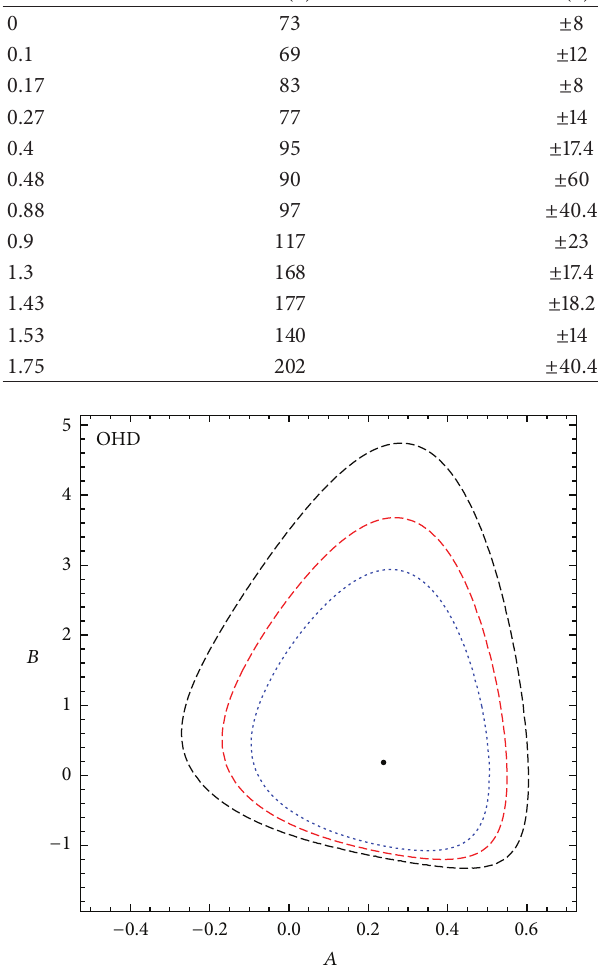
Figure1:Itshowsthevariationsof 𝐴 with 𝐵 for 𝛼 = 0.1 forOHDand OHD + BAO analysis, respectively, for different confidence levels say 66% (solid, blue), 90% (dashed, red), and 99% (dashed, black)